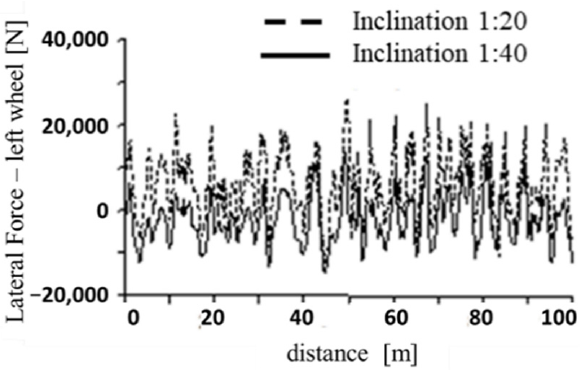
Figure 14. The lateral force on the left wheel for various rail inclinations.